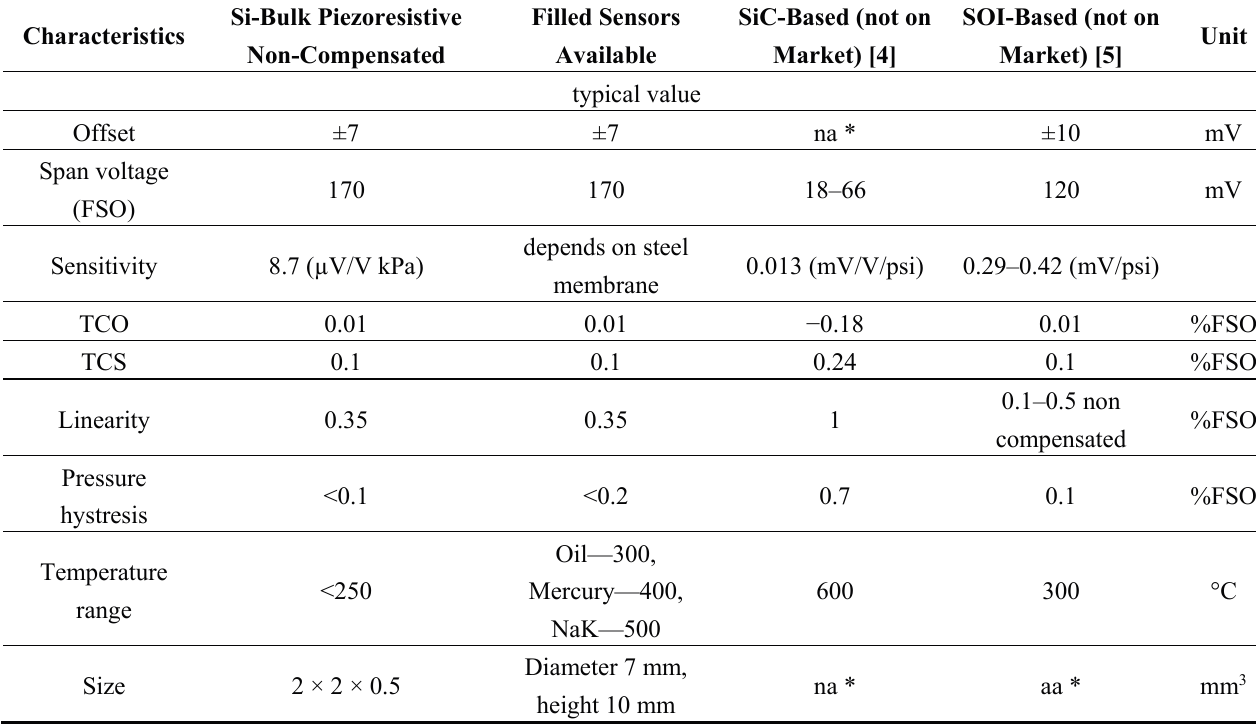
Table 1. State-of-art pressure sensors for high temperature